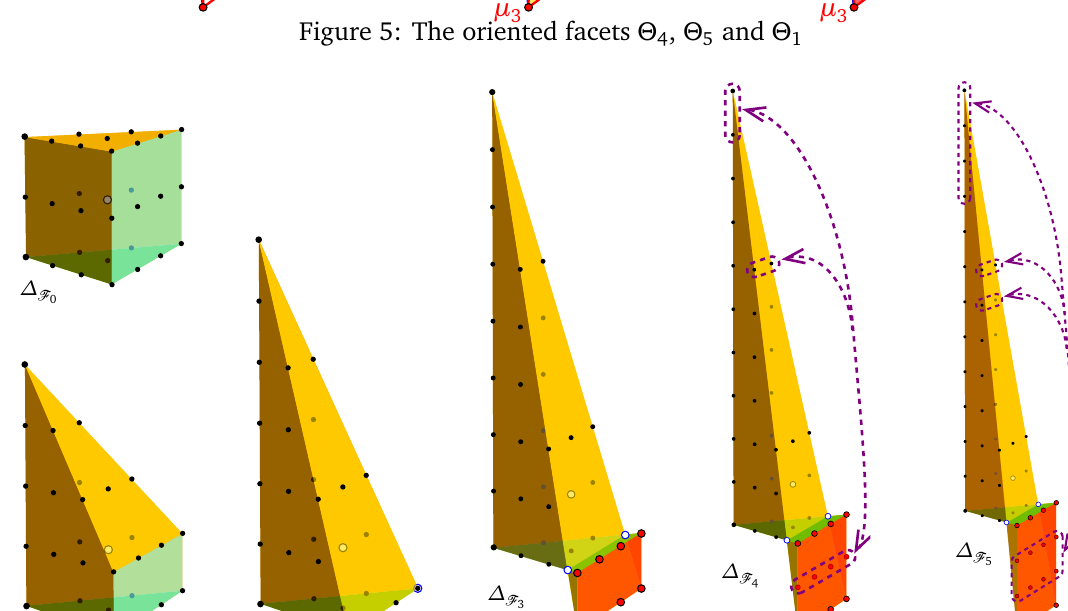
Figure 5: The oriented facets Θ